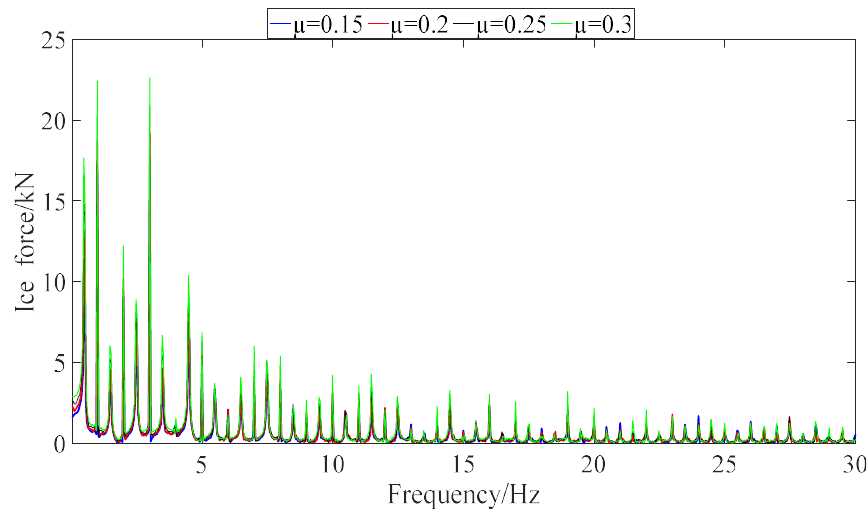
Figure 25. Time history curves of total ice force under different friction coefficients (µ).